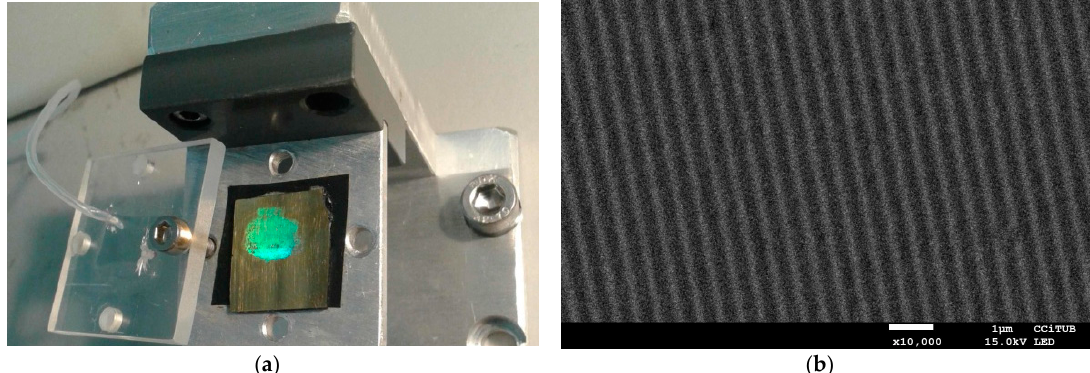
Figure 1. ( a ) Photograph of the area of the gold film patterned with a diffraction grating; ( b ) Scanning Electron Microscope photograph of the Λ = 500 nm period diffraction